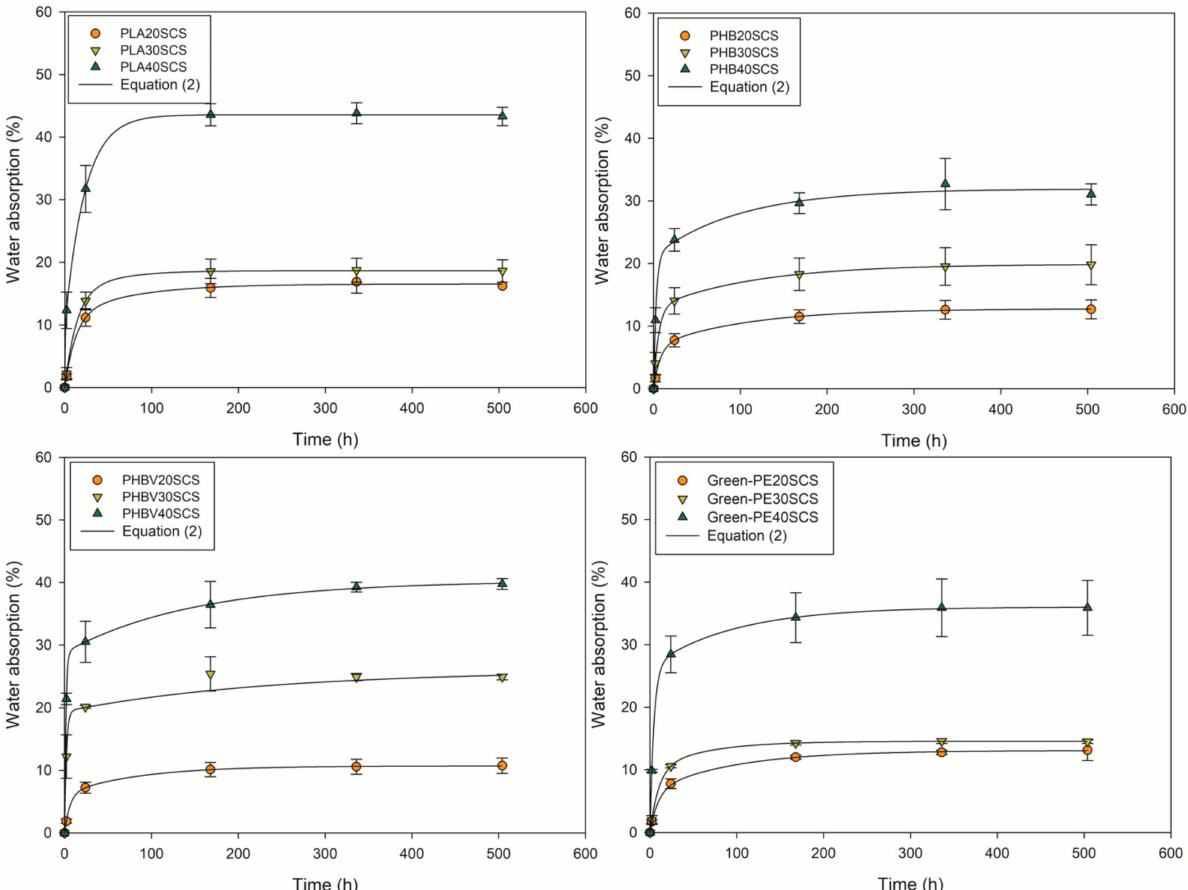
Figure 8. Water absorption curves of the biocomposites fitted to the hindered diffusion